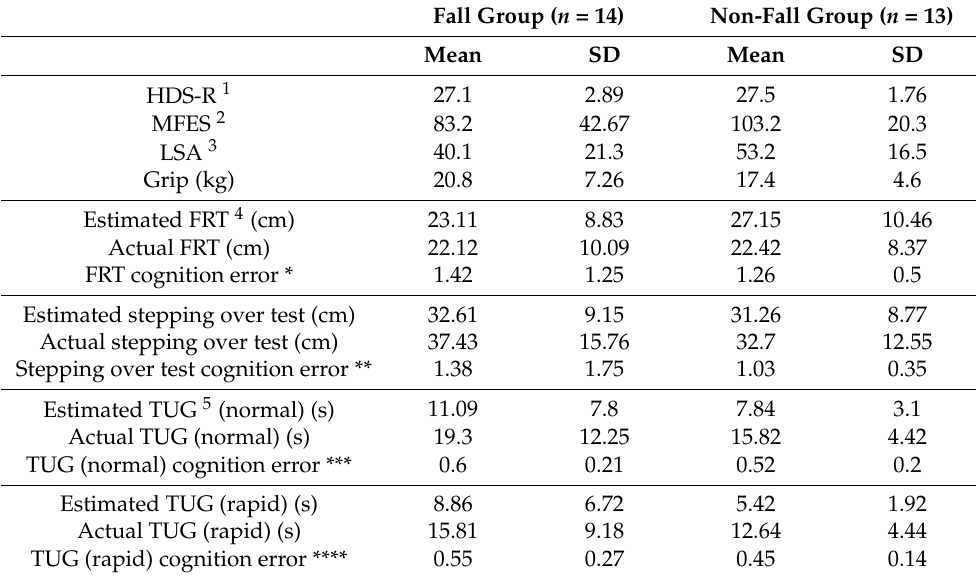
Table 2. Comparison of test results between the fall and non-fall groups.